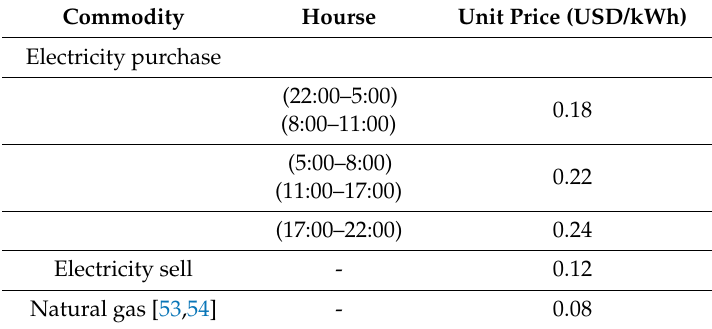
Table 2. Technical specification of each component. Table 4. Electricity 1 and natural gas price.